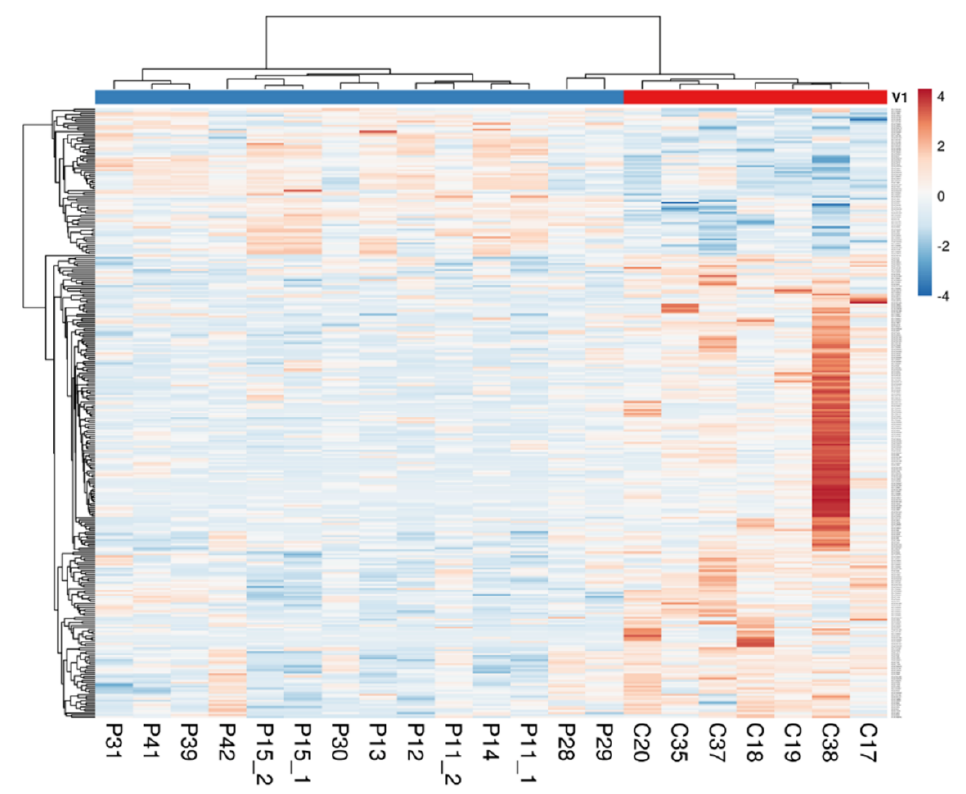
Figure 1. Heat map representation of the DE transcripts between NCWS and controls. Reddish and bluish colours represent upregulated and downregulated transcripts, respectively. The columns of the heat map represent the patients organised according to Canberra distance algorithm, whereas the rows represent the transcripts organised according to correlation distance. The code shown below the columns identifies a specific patient.